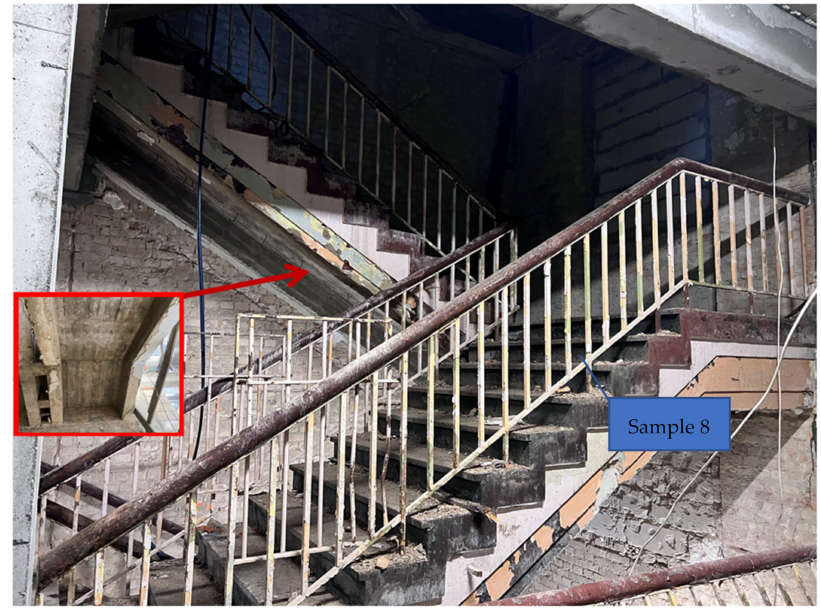
Figure 4. A view of the K2 staircase.